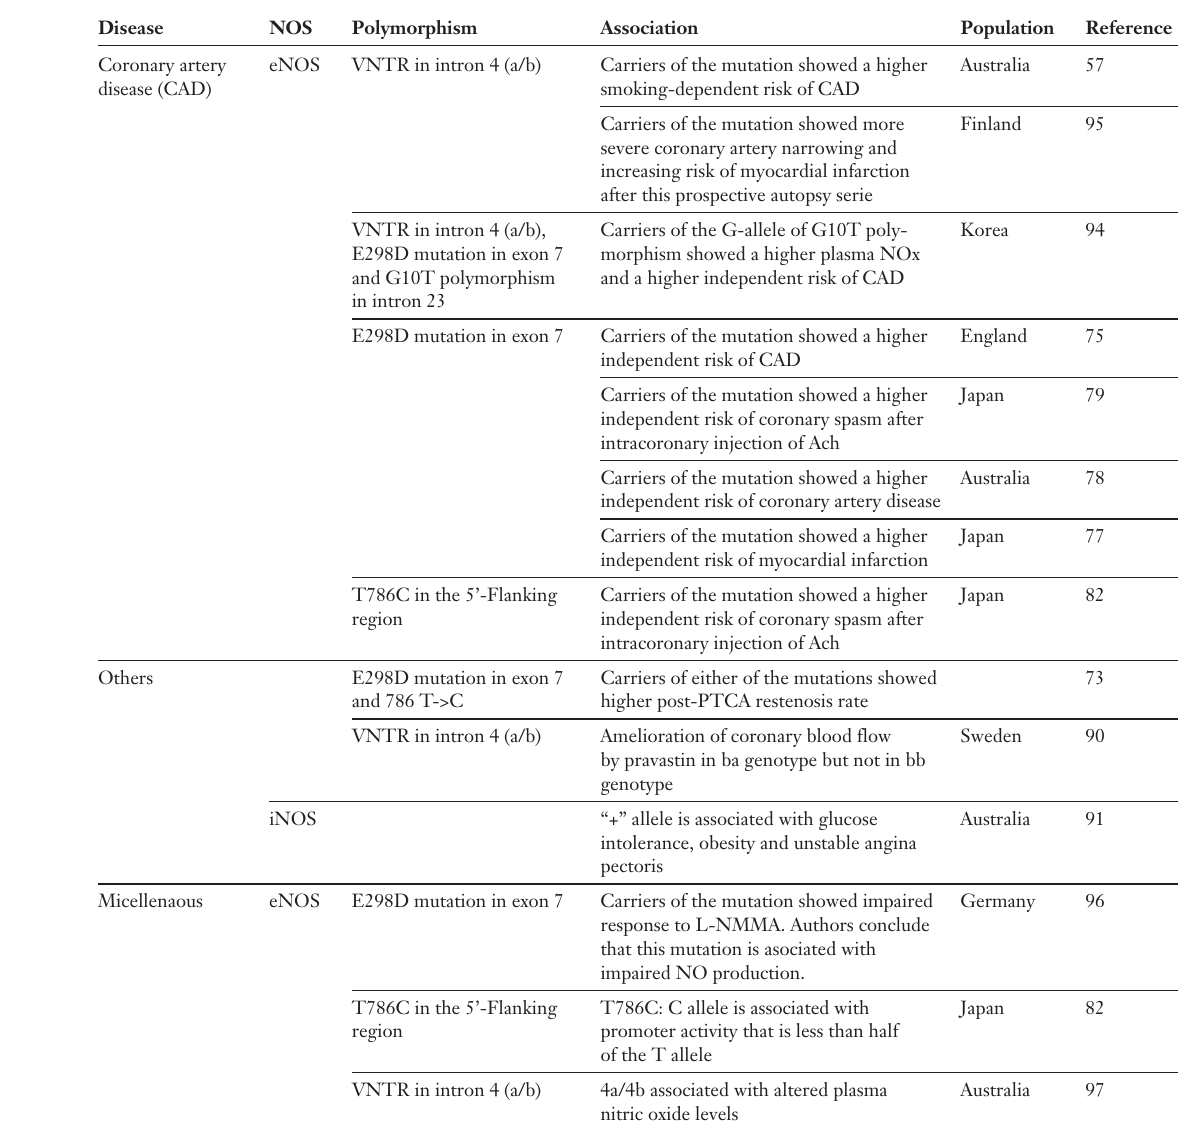
From NO imbalance to coronary events